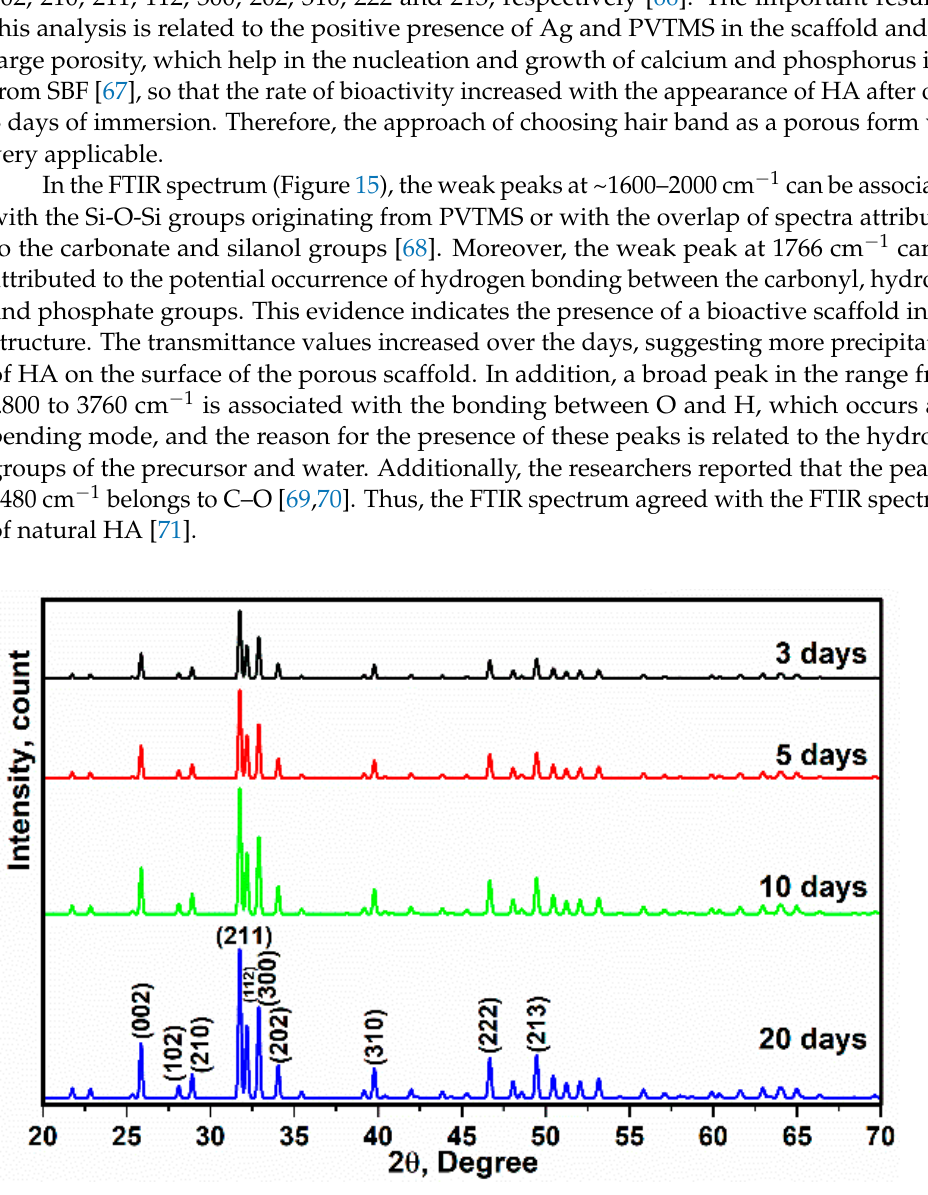
Figure 13. Synthesis of SBF [29], immersed scaffold in the SBF at 37 °C. The X-ray diffraction and FTIR spectra, as well as the SEM images and EDAX data